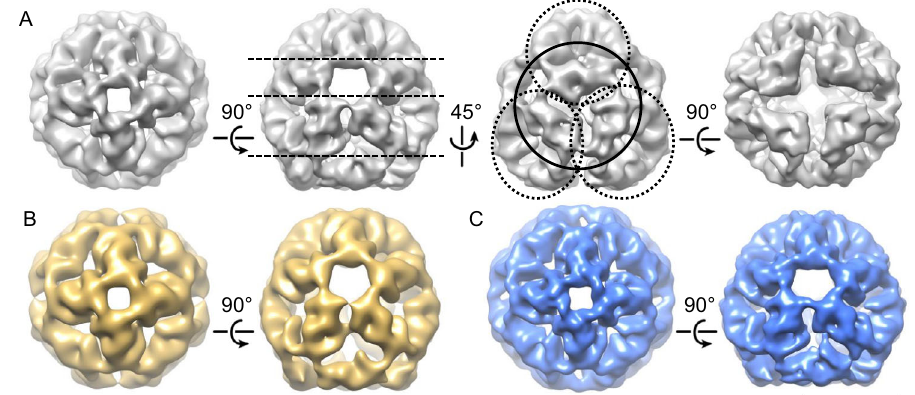
Fig. 3 Surface map views of cryo-EM reconstructions. Surface map views of cryo-EM reconstructions thresholded to 83% of the expected volume. A Different views (top view, two side views, and a bottom view) of the WT protein (GSFSC resolution 8.2 Å). Top view and bottom view showing fourfold symmetry. The dashed lines in the second view separate the dimer ring stacks. The circle (continuous line) indicates one hexamer while the circles with the dashed line are indicating the three corresponding overlapping hexamers. B Two exemplary views of the S47E/T48E mutant 40mer (GSFSC resolution 12 Å). C Two exemplary views of the S207E mutant 40mer (GSFSC resolution 7.3 Å). Side view (90° from view A). The length of the scale bar is 10